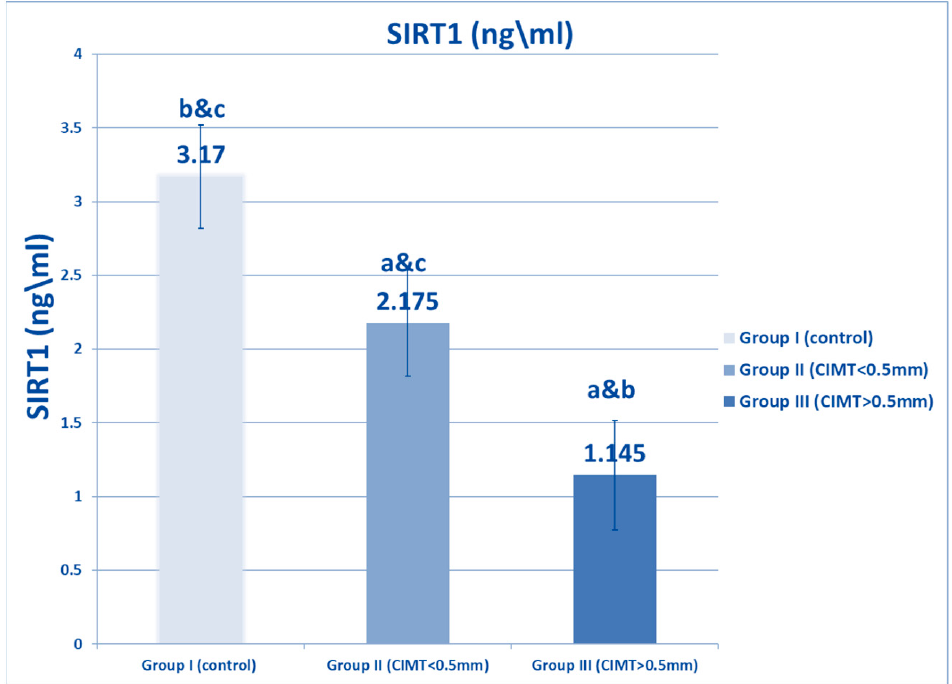
Figure 1. Comparison between studied groups with regard to SIRT1 level. Data are represented as mean ± SD ( n = 50 in each group). Statistical analysis was carried out using one-way ANOVA with Tukey’s post hoc test, SPSS computer program. a–c: Significant difference between groups at * p < 0.05. a: significance from Group I; b: significance from Group II; c: significance from Group III.